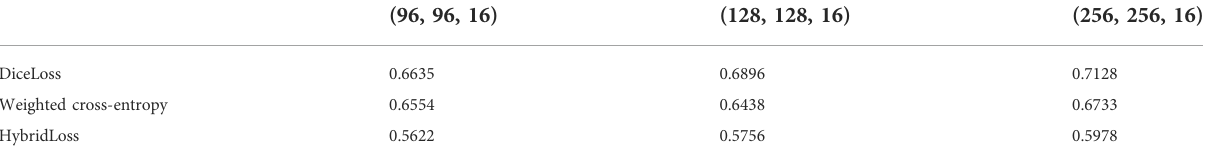
TABLE 3 DSC values for different patch sizes and loss functions of the test set.